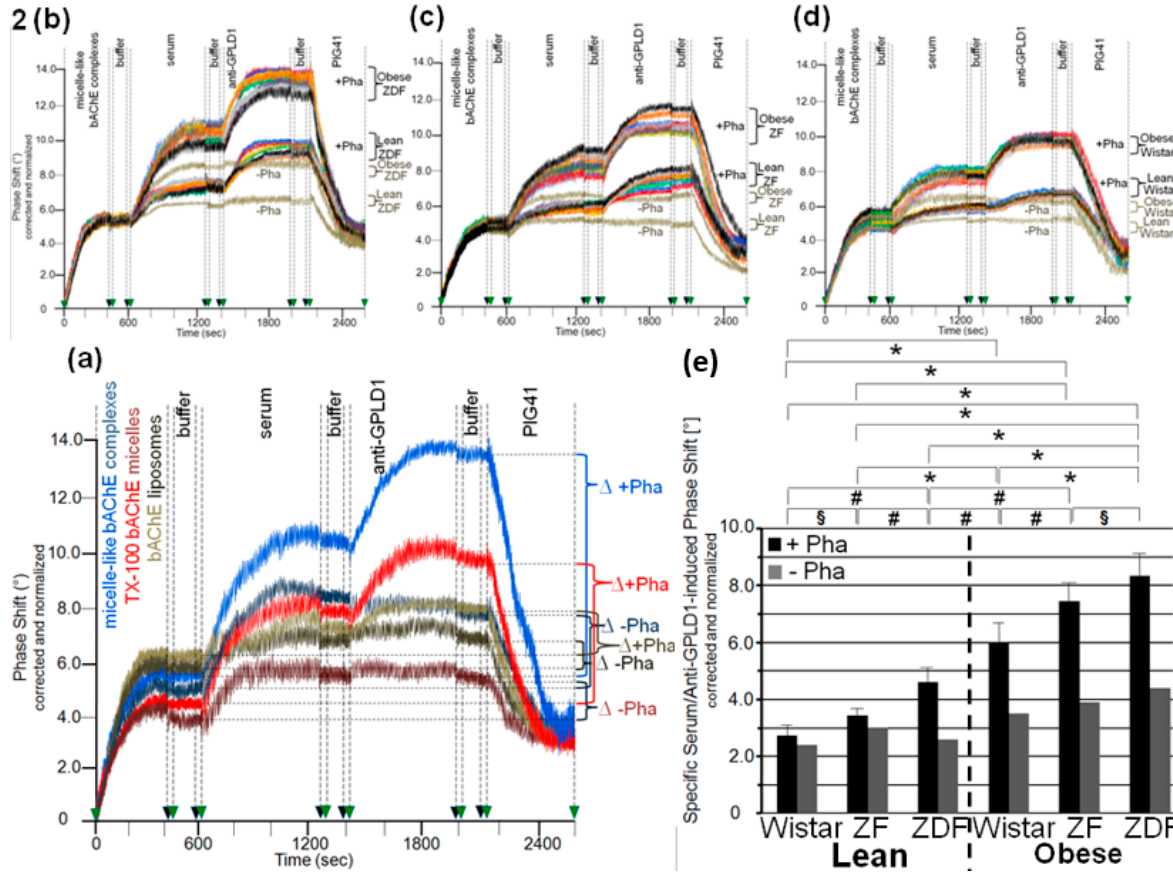
Figure 2. Measurement of the interaction of GPLD1 and other proteins from rat serum with micelle-like bAChE complexes. ( a – d ) bAChE reconstituted into micelle-like complexes at the “optimized” constituent ratio, liposomes ( a only), and TX-100 micelles ( a only) were injected into α -toxin-coated chips. Following washing of the chips with buffer, identical volumes of serum from obese ZDF rats ( a ) or from the six rat groups as indicated ( b – d ) were injected in the presence or absence of Pha (0.5 mM) as indicated. After washing with buffer, anti-GPLD1 antibody, buffer, and PIG41 (30 µ M) in the presence or absence of Pha (corresponding to the serum injection) were injected in sequential fashion. Correction and normalization of the phase shift were performed as described for Figure 1. ( a ) The total combined serum- and anti-GPLD1 antibody-induced phase shift is indicated as the difference ( ∆ ) between termination of antibody injection with subsequent washing (2100 s) and termination of the coating of the chips with subsequent washing prior to injection of serum (600 s). ( b – d ) Comparisons between the six rat groups were performed with the same chip each and repeated three times (different preparations of micelle-like bAChE complexes) with similar results (16 regeneration cycles per chip; representatives shown). ( e ) The specific combined serum- and anti-GPLD1 antibody-induced phase shift was calculated as the difference between the total phase shift (see a ) and the unspecific phase shift remaining left at the end of PIG41 injection (2600 s). The phase shifts determined in the presence of Pha ( n = 8; means ± SD, triplicate measurements, black bars) or absence of Pha ( n = 1; duplicate measurements, grey bars) are given. The comparison between the groups is shown for the samples coinjected with Pha (black bars) only (* p ≤ 0.01, # p ≤ 0.02, § p ≤